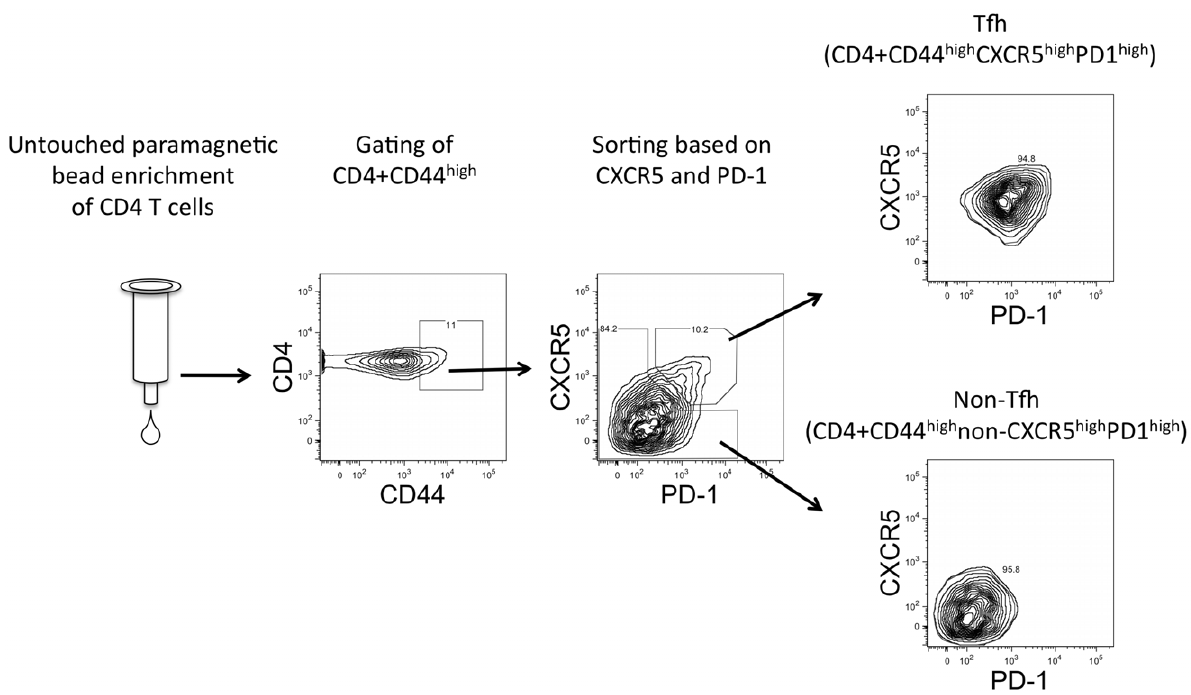
Figure 2. Schematic of sorting strategy used to separate Tfh from non-Tfh cells. CD4 + T cells are first enriched from draining lymph node cells with untouched paramagnetic bead separation. The CD4 + T cell enriched population is then stained for CD4, CD44, CXCR5, and PD1 and cytometry is used to sort stained cells by first gating on the CD4 + CD44 high population and then separating Tfh from non-Tfh cells. Values displayed on plots are the percent of the population within each gate and are indicative of a representative experiment.